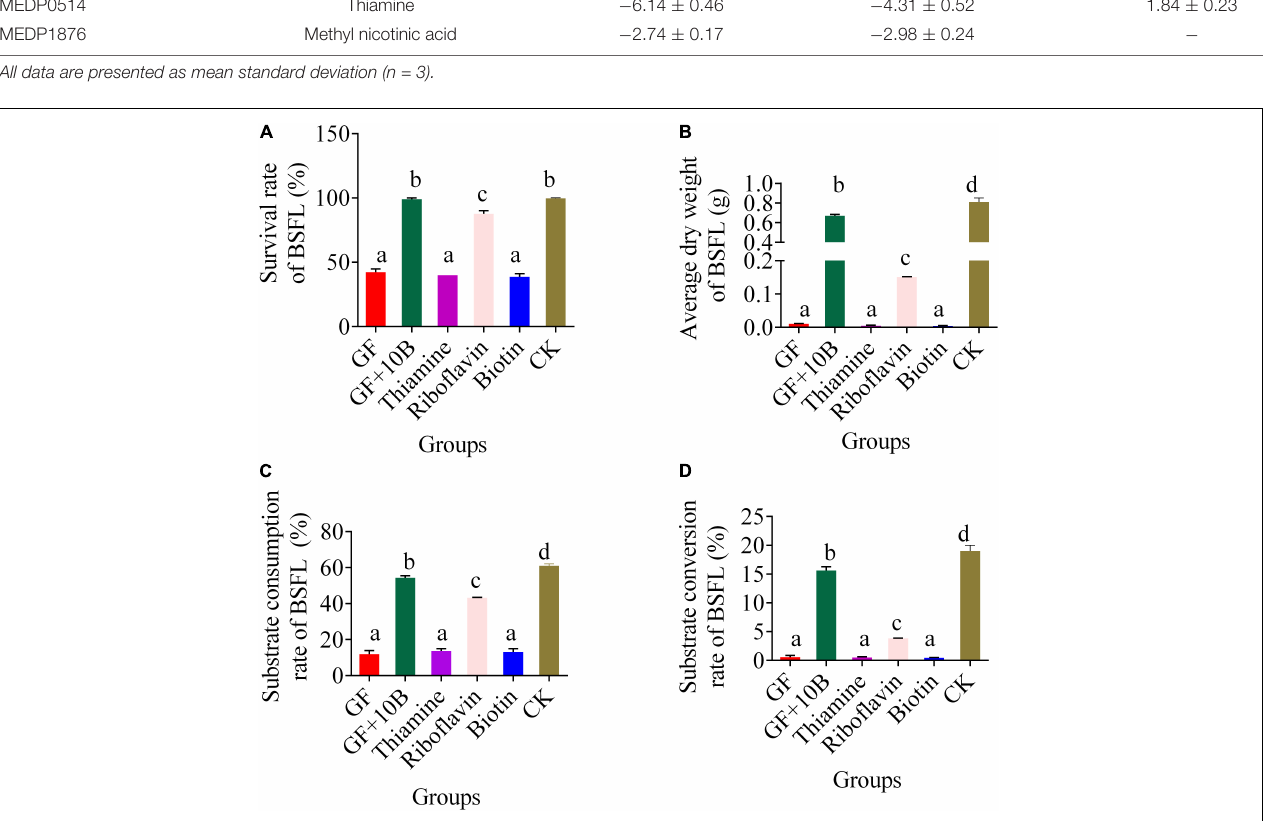
FIGURE 8 | The bio-physiological parameters, namely, (A) survival rate, (B) average dry weight, (C) substrate consumption rate, and (D) substrate conversion rate of BSFL in the GF, GF + 10B, thiamine, riboflavin, biotin, and CK groups. GF, germ-free BSFL fed on sterile food waste; GF + 10B, germ-free BSFL fed on sterile food and 10B; thiamine, germ-free BSFL fed on sterile food waste and 1 ml thiamine (5 mg/ml); riboflavin, germ-free BSFL fed on sterile food waste and 1 ml riboflavin (5 mg/ml); biotin, germ-free BSFL fed on sterile food waste and 1 ml biotin (5 mg/ml); CK, natural BSFL fed on sterile food waste. Data are presented as mean ± standard deviation ( n = 3). Values with different letters mean significant differences at p < 0.05, as determined by Tukey’s test.